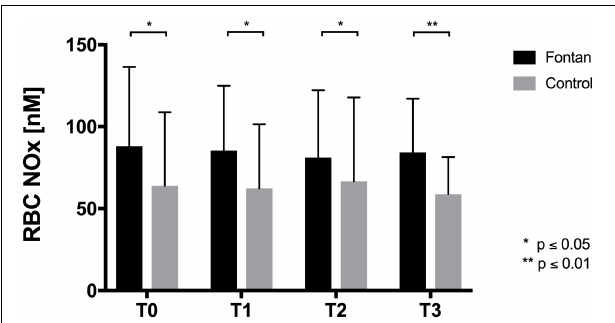
FIGURE 4 | RBC NOx concentration RBC of Fontan patients showed significantly higher NOx levels compared to healthy controls at all timepoints, but NOx concentrations remained unaltered during intervention.